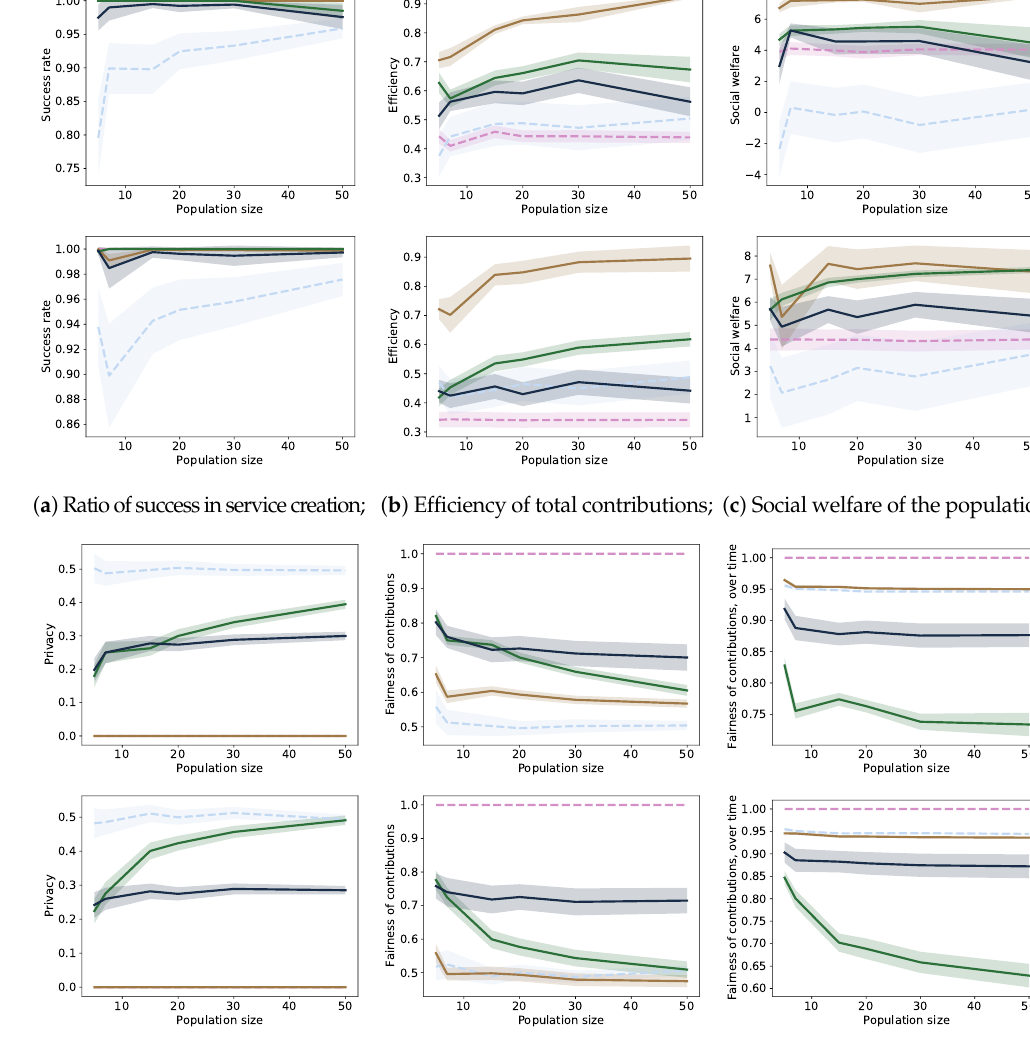
( e ) Average fairness of contributions; ( f ) Average fairness over time. Figure A1. Dependence of results on the population size ( x -axis). Dashed lines represent baselines, solid lines represent contribution strategies. The plots show that most measures are independent of the population size. This result is driven by the assumption that the public good threshold is proportional to the size of the population. If this threshold were constant, successfully generating the public good would become easier with an increase in the number of agents/contributors. Aspiration learning is the algorithm with the highest dependency on population size, as a larger population size leads to higher efficiency and privacy, as well as lower fairness. This result can depend on the lack of contextual information in aspiration learning, in contrast to Q-Learning, which could lead to reduced performance for smaller and less flexible